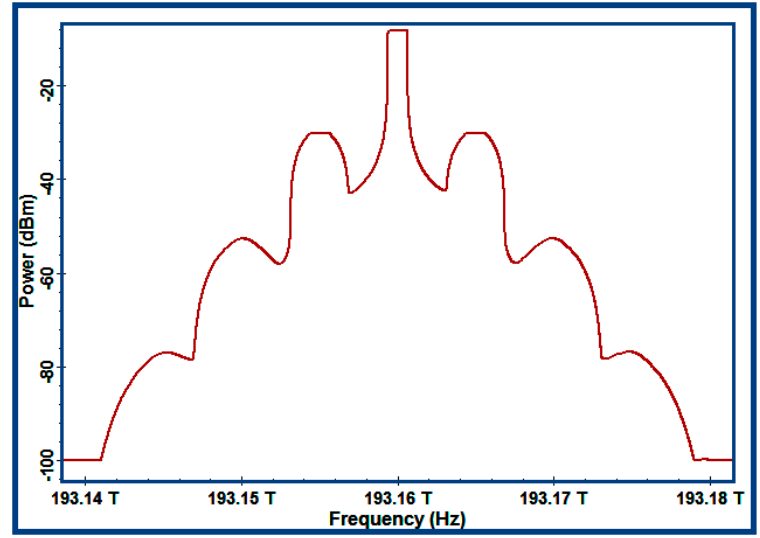
Figure 7. The optical spectrum of the double-sideband optical signal.